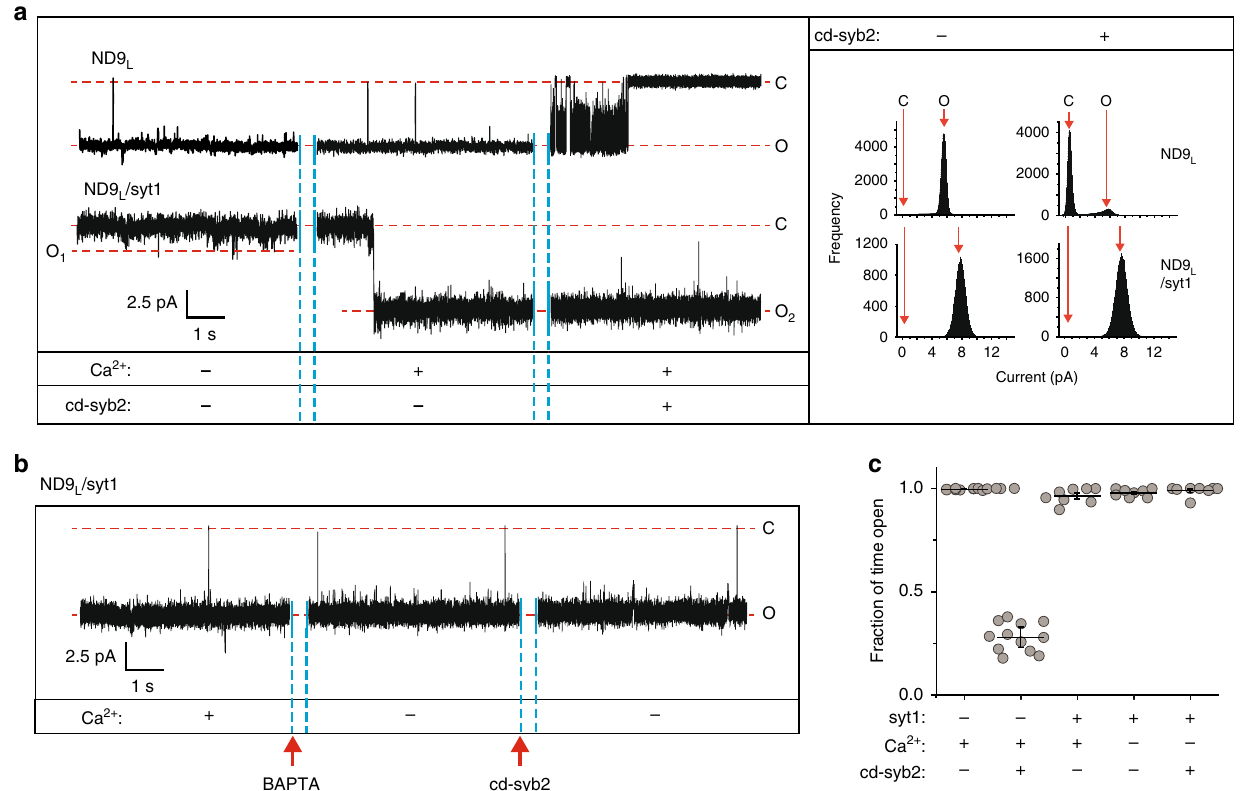
Fig. 5 Ca 2 + (cid:129) syt1 drives trans -SNARE complexes into a functionally committed state. a Representative recording of ND9 L lacking or containing syt1. Once pores were open, 20 µ M cd-syb2 was added to each reaction. Closed (C) and open (O) states are indicated; the current/time scale for all traces is shown in the inset, left. Right panel: respective current histograms are shown. b Representative recordings of ND9 L bearing syt1 in 500 µ M [Ca 2 + ] free are shown, followed by the addition of 1.5 mM BAPTA (arrow), further followed by 20 µ M cd-syb2 (arrow). The current/time scale is shown on the bottom left. c Fraction of time individual pores were open over a 45-min period, plotted for each condition as indicated. Error bars indicate SEM from 12 and 8 independent BLMs for a and b , respectively; 3 independent sets of NDs were